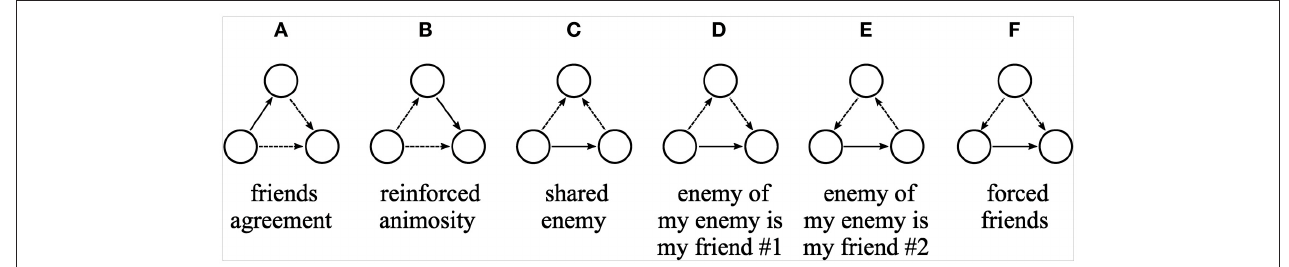
FIGURE 1 | Balanced triads. Graphical representations illustrating different processes through which the creation (or maintenance) of the tie presented in the base of the triangle creates (or maintains) balance. Solid lines represent friendship ties and dotted lines antipathy ties. Arrow heads indicate who is directing the tie toward